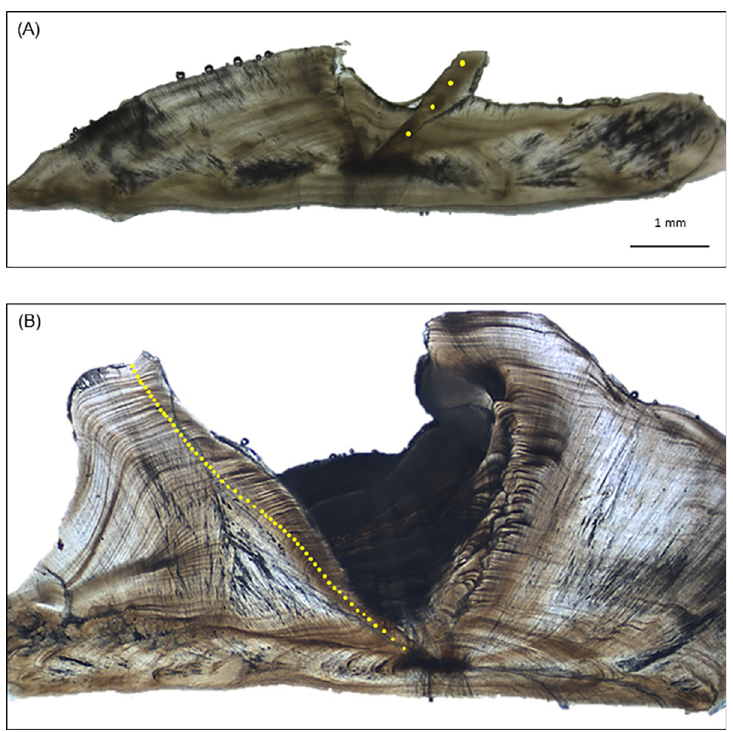
Fig 1. Images of Warsaw grouper otolith sections. Images of Warsaw grouper sagittal otolith sections viewed with transmitted light. Panel A is from a 974 mm TL fish estimated to be 4 years old. Panel B is from a 1,954 mm TL fish estimated to be 59 years old and for which the core of the right otolith was extracted and analyzed for Δ 14 C (sample WRG-0675). Scale bar shown in Panel A is the same for Panel B.